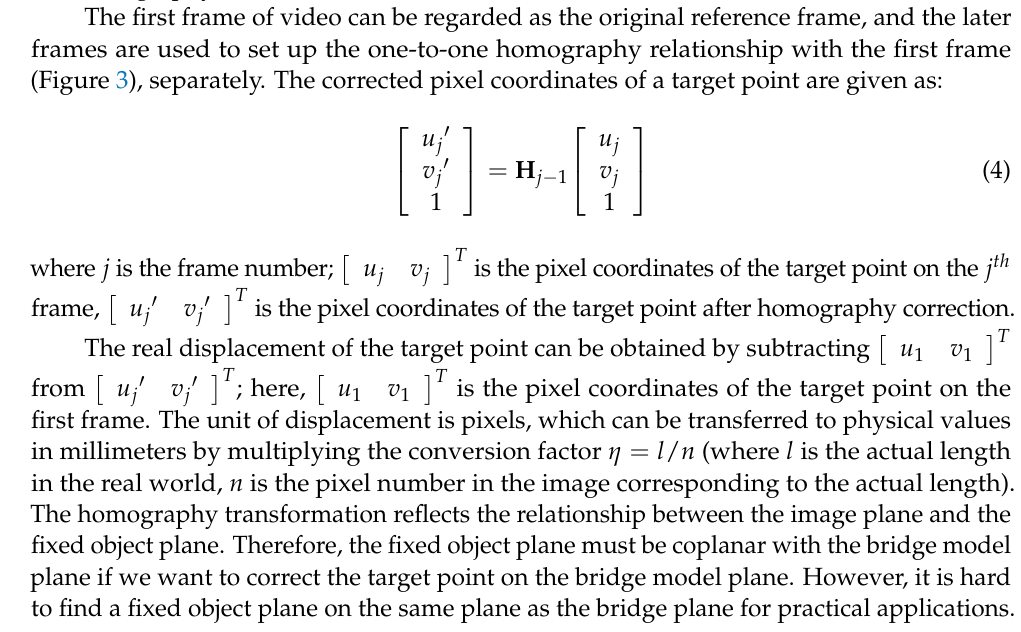
raphy correction.